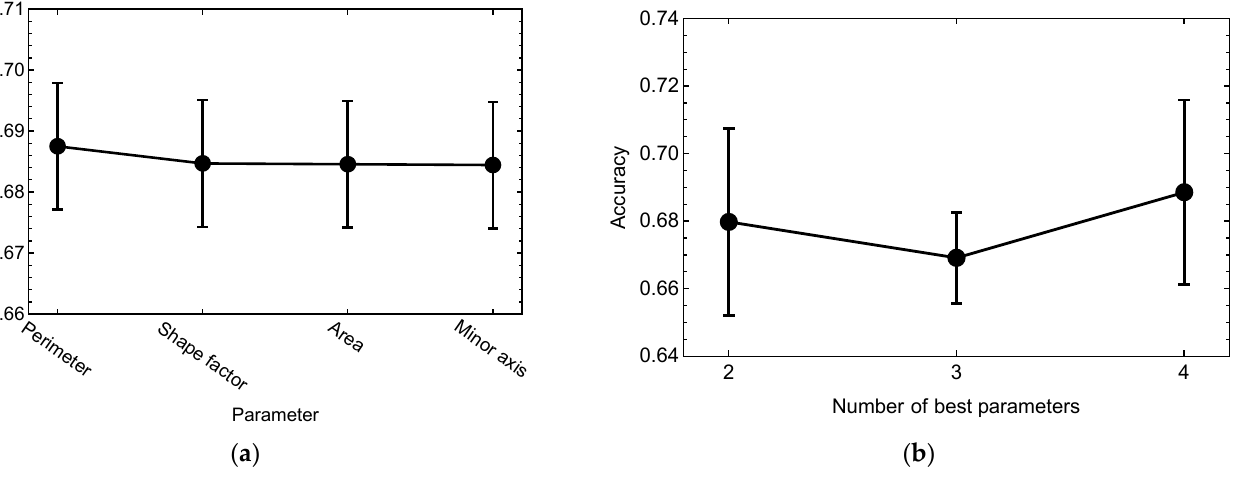
Figure 7. Same as in Figure 6 but for classification models based on the four cellular morphological parameters. ( a ) Importance measure for each parameter. ( b ) Mean cross-validation accuracy of the models containing a given number of the best parameters from ( a ). Combinations of best parameters in ( b ): 2, Perimeter and Shape factor; 3, Perimeter, Shape factor, and Area; 4, Perimeter, Shape factor, Area, and Minor axis.